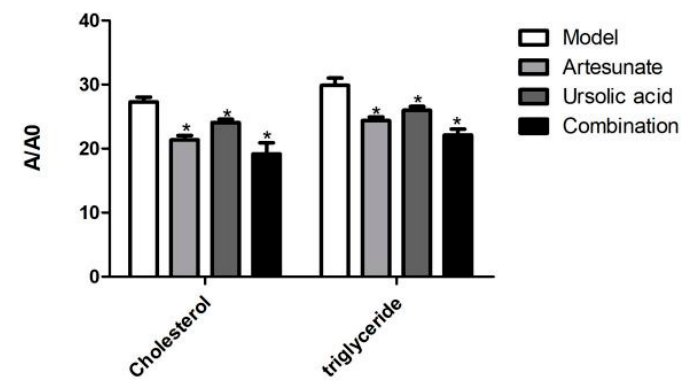
Figure 6. The relative intensity of cholesterol and triglycerides of each administration group in the serum. The groups were divided as four groups: model group; artesunate group (20 mg/kg); ursolic acid group (20 mg/kg); combination group (artesunate 20 mg/kg + ursolic acid 20 mg/kg). A/A0 is expressed by its peak area normalized against that of the internal standard. Values are represented as mean ± SD. Significant difference vs. the model group (* p < 0.05). Many long chain fatty acids, such as hexadecanoic acid, palmitelaidic acid, arachidonic acid, tetracosanoic, undecanoic acid, and ( E )-11-Eicosenoic acid were decreased in the artesunate group and the combination group (Figure 7).